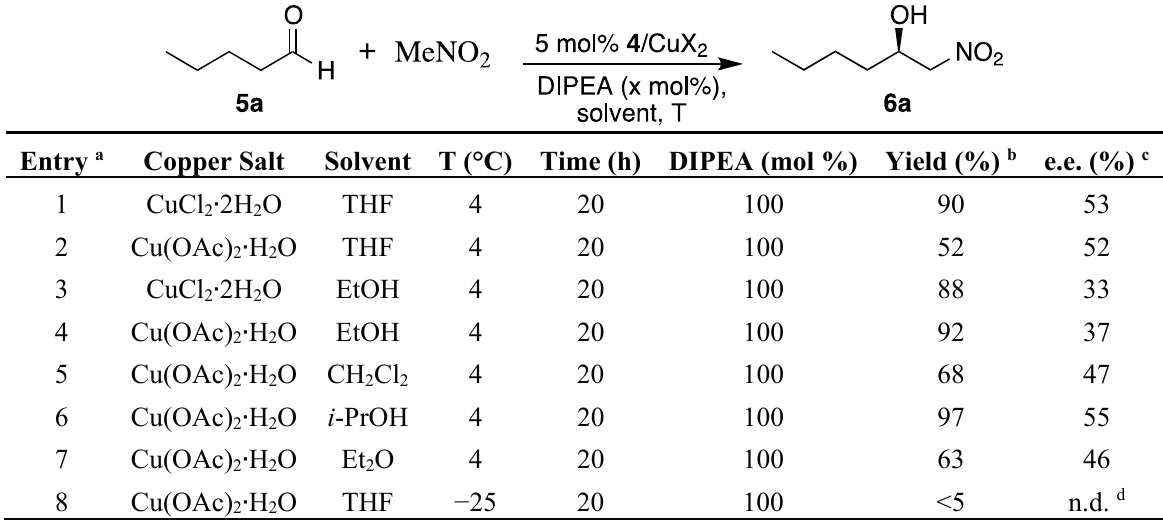
Table 1. Selected experimental conditions for asymmetric Henry reaction between pentanal and